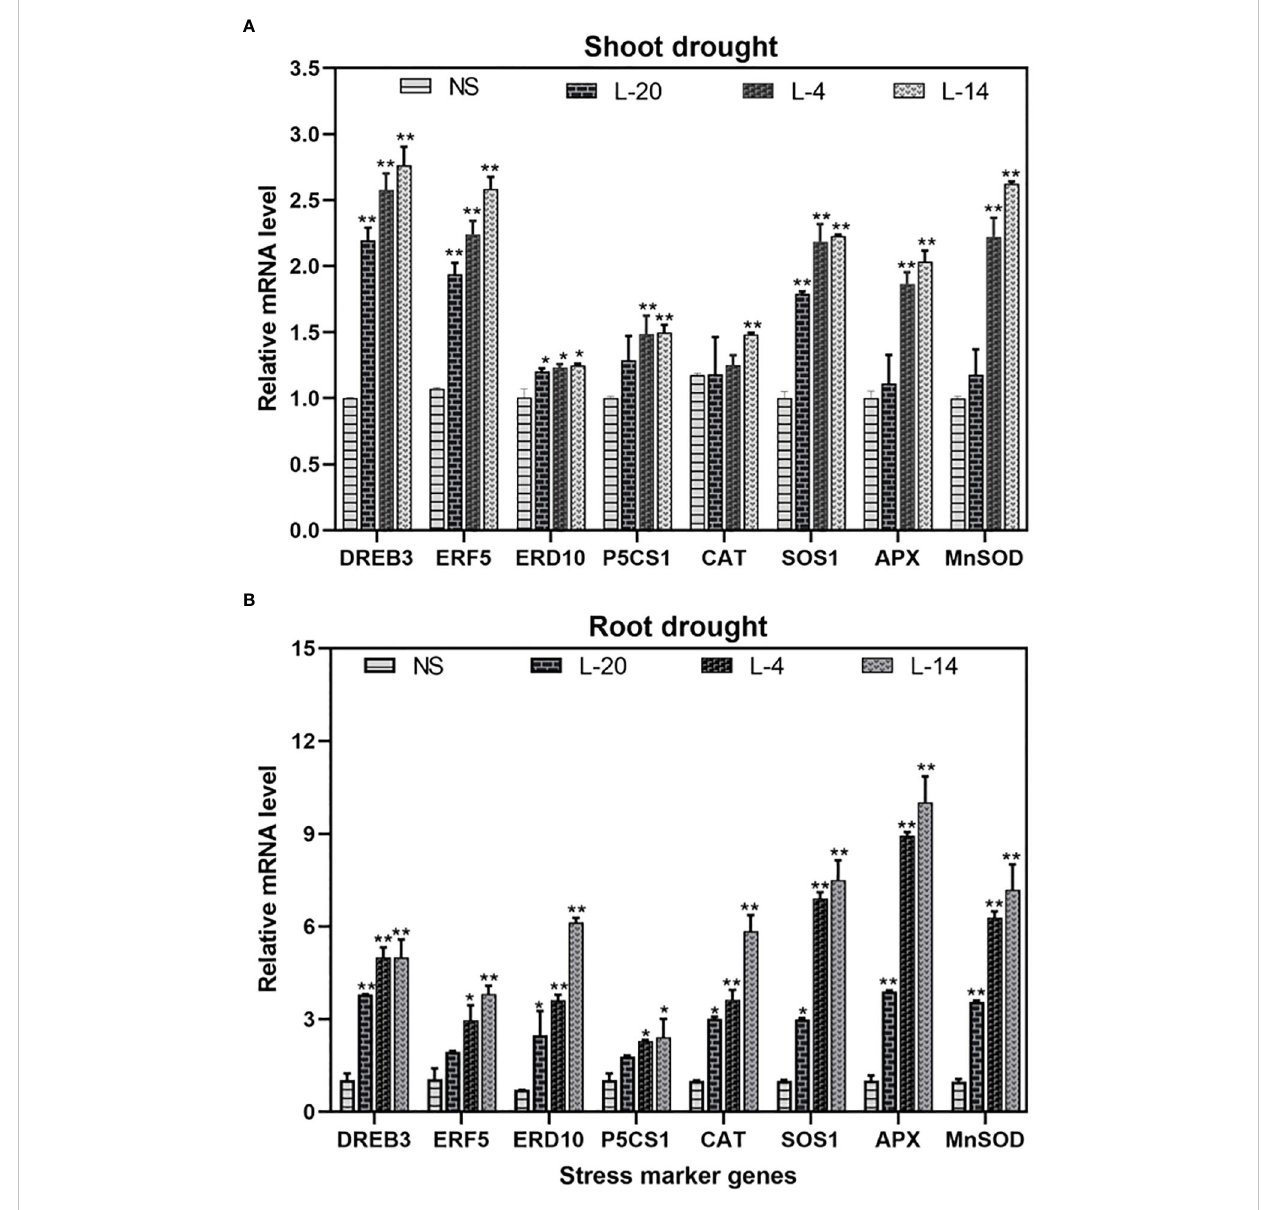
FIGURE 10 Relative expression analysis of stress- marker genes in (A) Shoot (B) Root of NS and VaDJI transgenic tobacco plants by using qRT-PCR. Plants of tobacco after 14 days of drought stress were used for the expression analysis. Relative expression was normalized with the mean of ADH3 and UBI genes as endogenous control. Livak and Schmittgen ’ s DD C T method was used to calculate the expression level. The experiment here included three biological and three technical repeats. Values are mean ± SE (*at p ≤ 0.05 value and **at p ≤